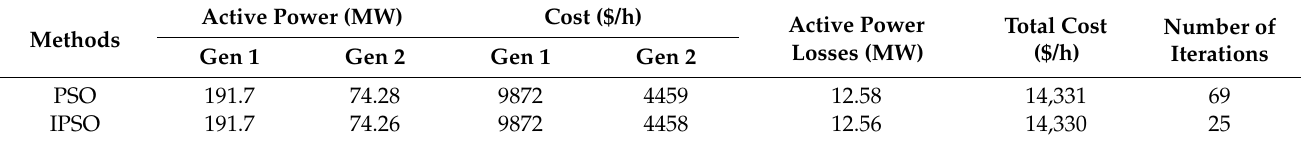
Table 2. Comparison of the generation costs of the PSO-OPF and IPSO-OPF methods.